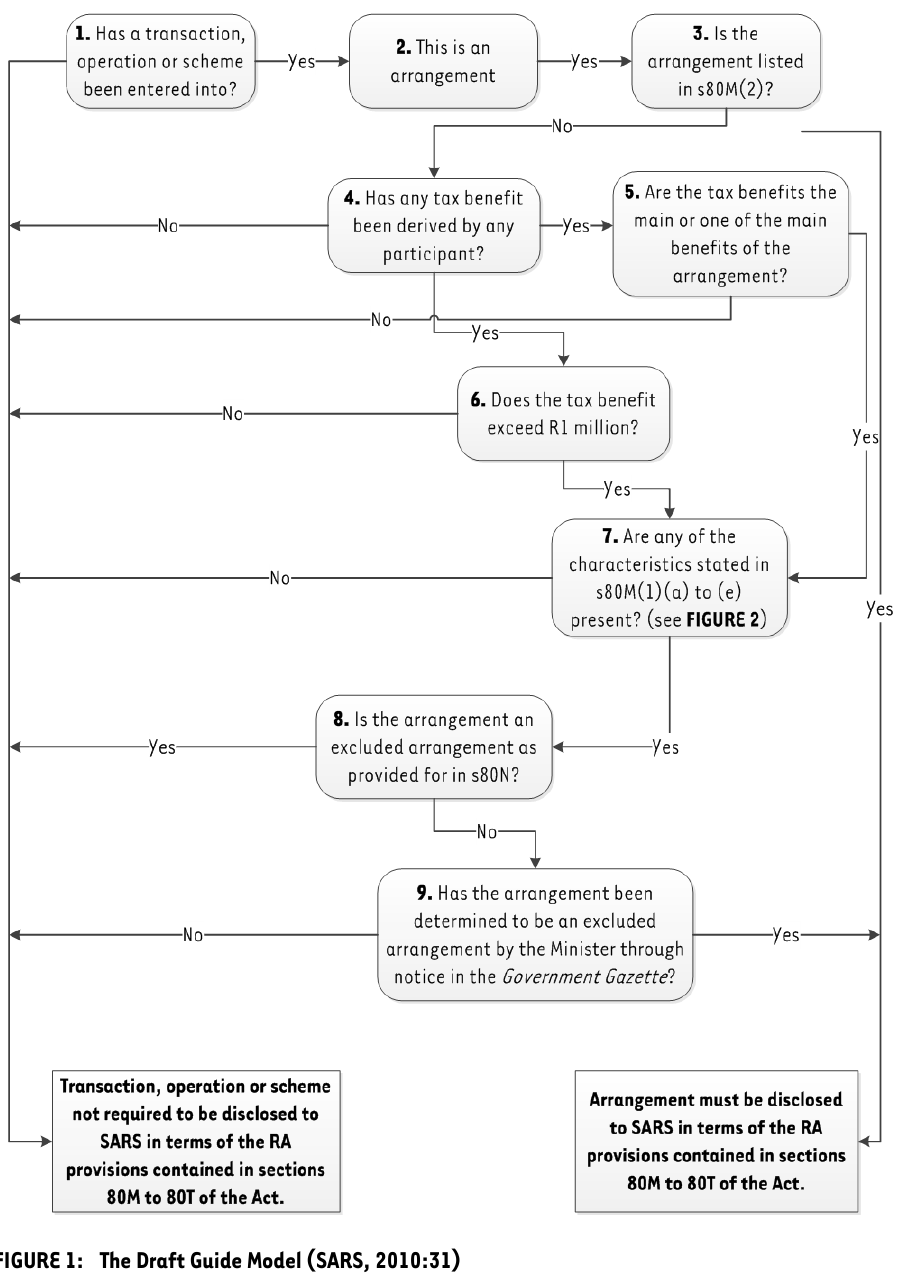
FIGURE 1: The Draft Guide Model (SARS, 2010:31) Source: SARS Draft Guide to Reportable Arrangements(SARS,